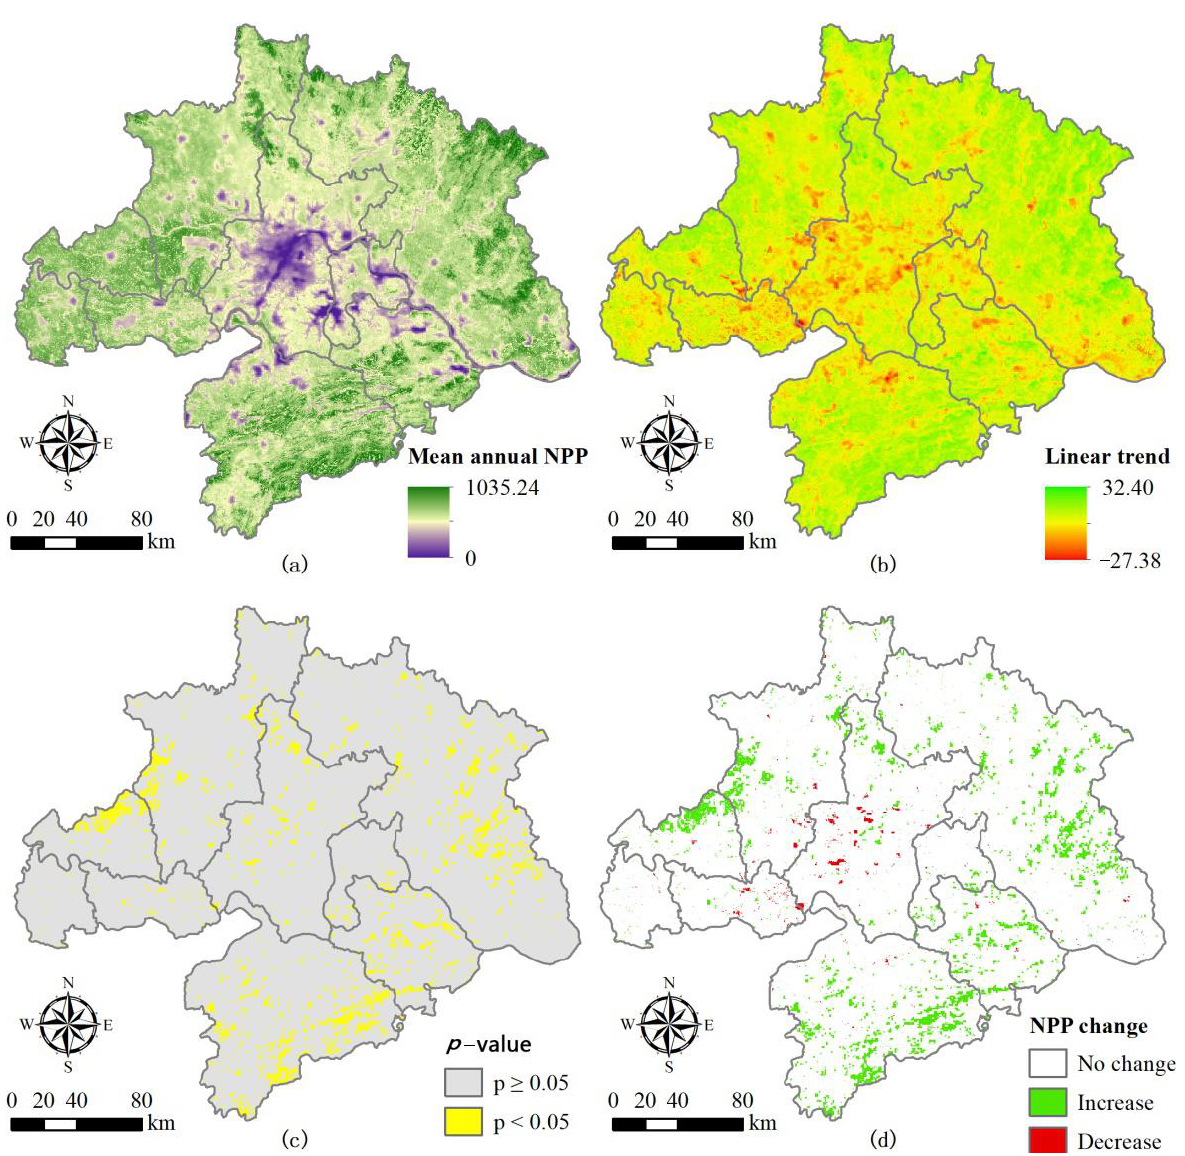
Figure 3. Spatiotemporal variations of annual NPP (gC × m −2 ) in the Wuhan City Circle area at the pixel level. Average annual NPP ( a ), change trends in annual NPP ( b ), the p −value of t −test for the modeled slopes ( c ), and the NPP change types ( d ). Note: The least-square linear regression model was applied to analyze the temporal variation of annual NPP (Net Primary Productivity) from 2000 to 2015 for each pixel, and the changing trend is described by the modeled slope, i.e., a in Figure ( b ). In Figure ( d ), No change documents that annual NPP did not change ( a = 0 and p ≤ 0.05), or that the change was not significant ( a ≠ 0 and p > 0.05).